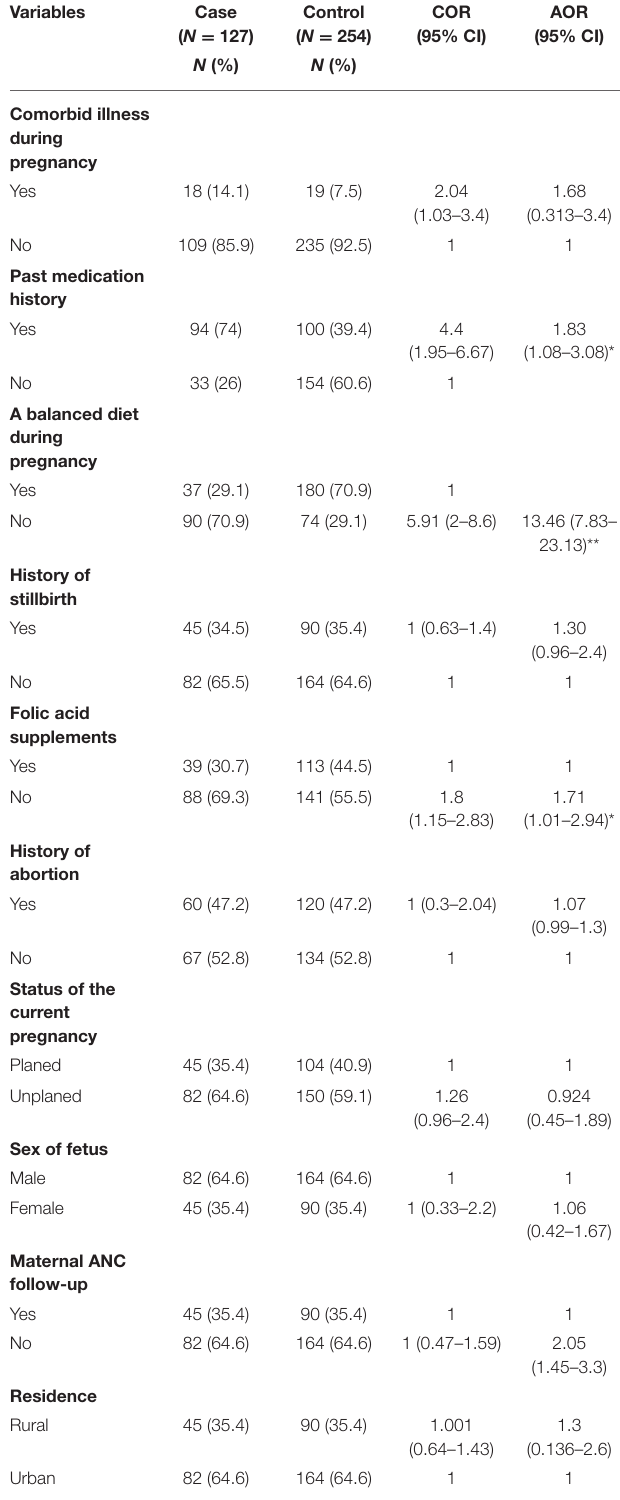
TABLE 4 | Bivariable and multivariable results for the factors associated with NTDs among newborns in Debre Berhan Specialized Hospital, 2021.